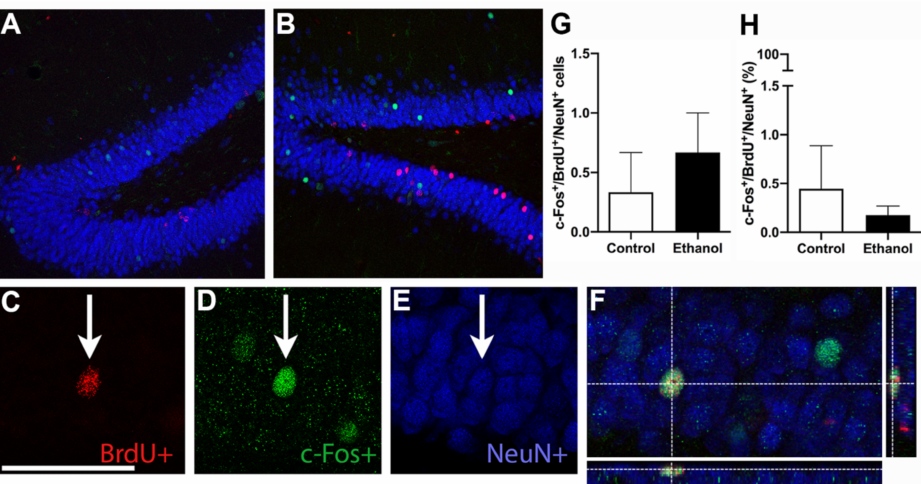
Figure 5. Incorporation of newly generated neurons: ( A , B ) Representative images of the dentate gyrus from control ( A ) and ethanol-exposed ( B ) animals for bromodeoxyuridine (BrdU)/c-Fos/NeuN triple-label immunoreactivity. ( C – F ) Higher magnification images for individual fluorochromes illustrating a BrdU+ cell ( C , red), a c-Fos+ cell ( D , green), and a NeuN+ cell ( E , blue), as well as a merged and rendered orthogonal z-stack of the triple-labelled (BrdU+/c-Fos+/NeuN+) cell ( F ). Unpaired t -tests revealed no significant differences in the ( G ) number or ( H ) percent of BrdU+ cells that also expressed cFos and NeuN (triple-labelled) between the controls and ethanol-exposed animals. GCL—granule cell layer. Bars represent means ± SEM. Scale bars = 40 µ